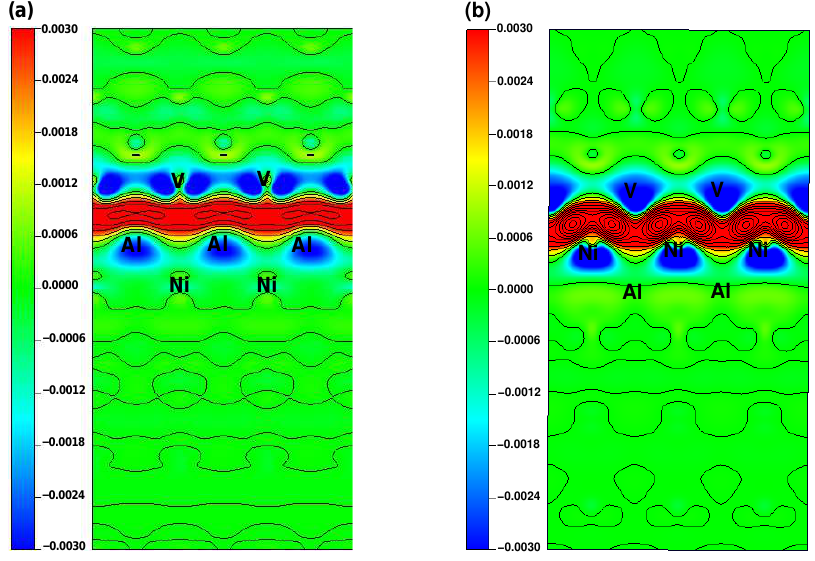
Figure 3. Charge density difference for ( a ) NiAlV and ( b ) AlNiV